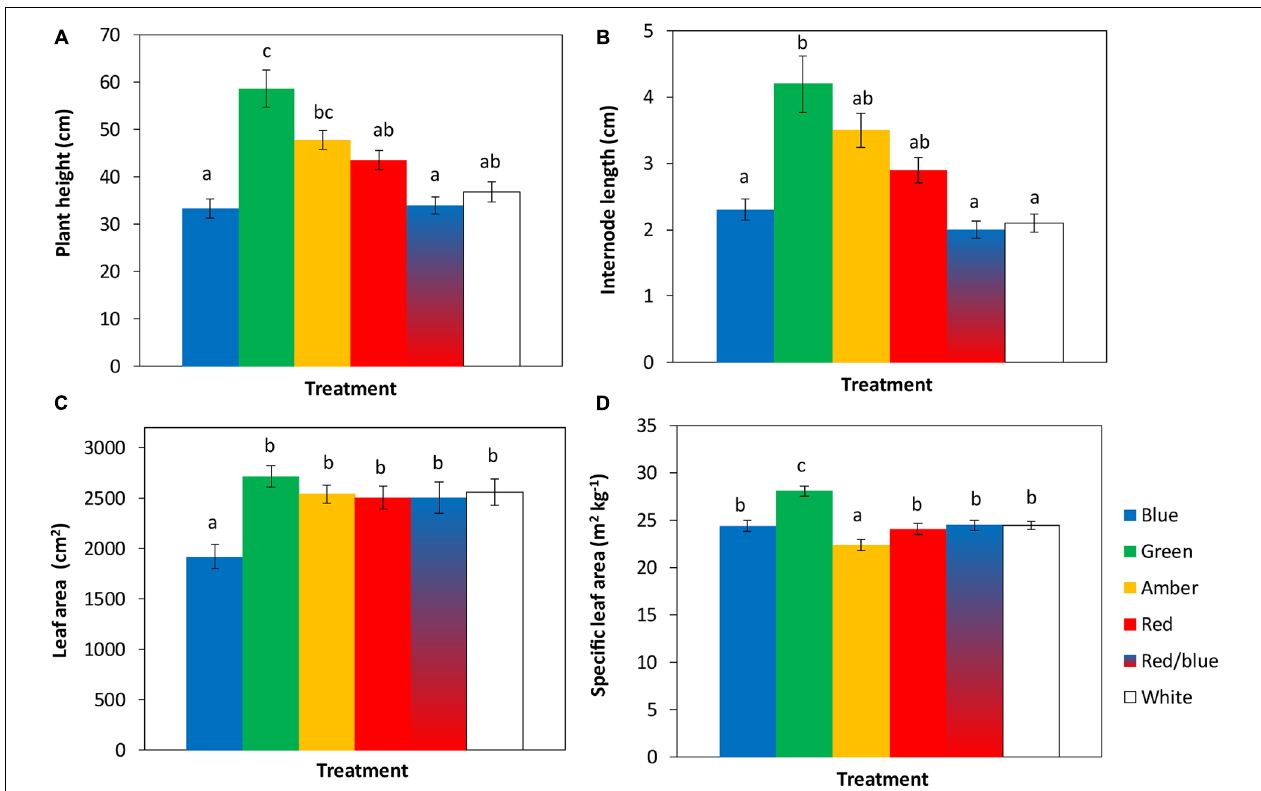
FIGURE 2 | Effects of spectral composition of the light during 21 days on plant height (A) , internode length (B) , leaf area (C) and specific leaf area (SLA) of the 6th leaf (D) , recorded at the end of the experiments ( n = 2, average of 10 plants). Vertical bars indicate the standard error of mean ( n = 2). Different letters indicate significant differences ( P <